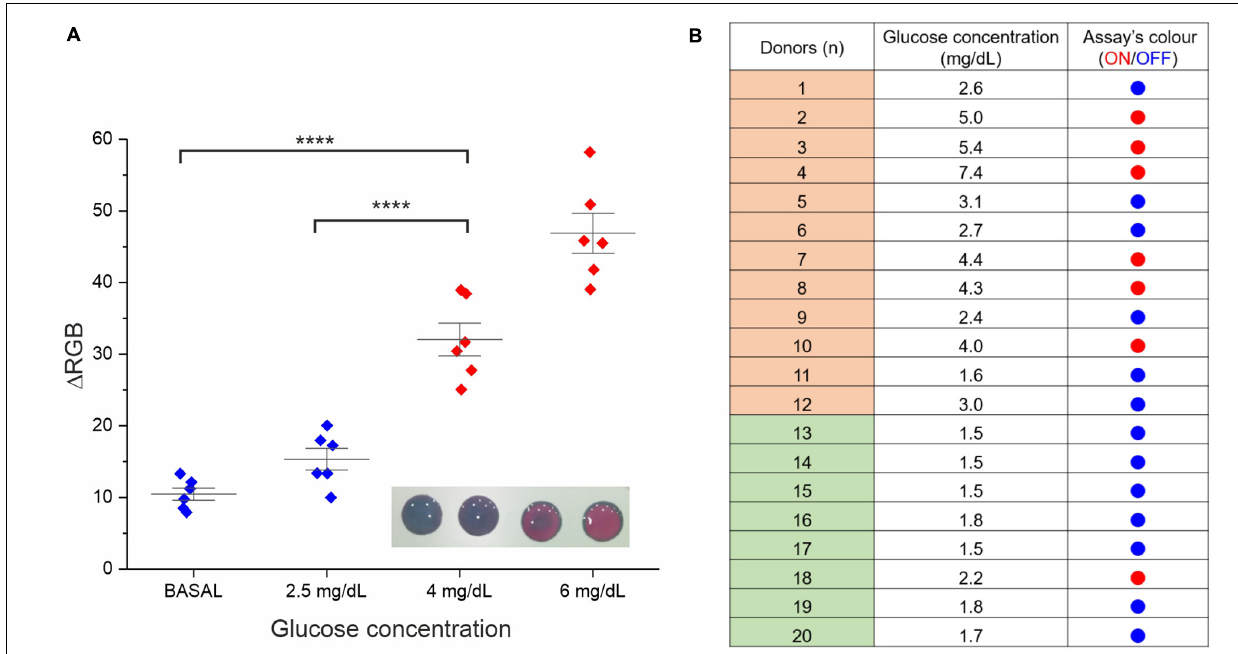
FIGURE 4 | Assay performance analysis in real saliva samples. (A) Validation of the RGB-based readout. Six saliva samples were involved in this study (the average of two experimental replicates is reported). Besides the basal glucose concentration, all samples were normalized through glucose spike at 2.5, 4, and 6 mg/dL, the RGB coordinates values were measured at t = 0 and 15 min with a smartphone app (ColorGrab), and the (cid:49) RGB was calculated. Statistical significance was determined using a one-way ANOVA and Tukey’s multiple comparison test (**** P < 0.0001). A representative image of the assay at the four different concentrations is reported in the inset. (B) Assay results for clinical saliva samples from both diabetic subjects (donors 1–12) and healthy subjects (donor 13–20). The “ON” outcome (red dots) refers to (cid:49) RGB ≥ 30 ± 10.